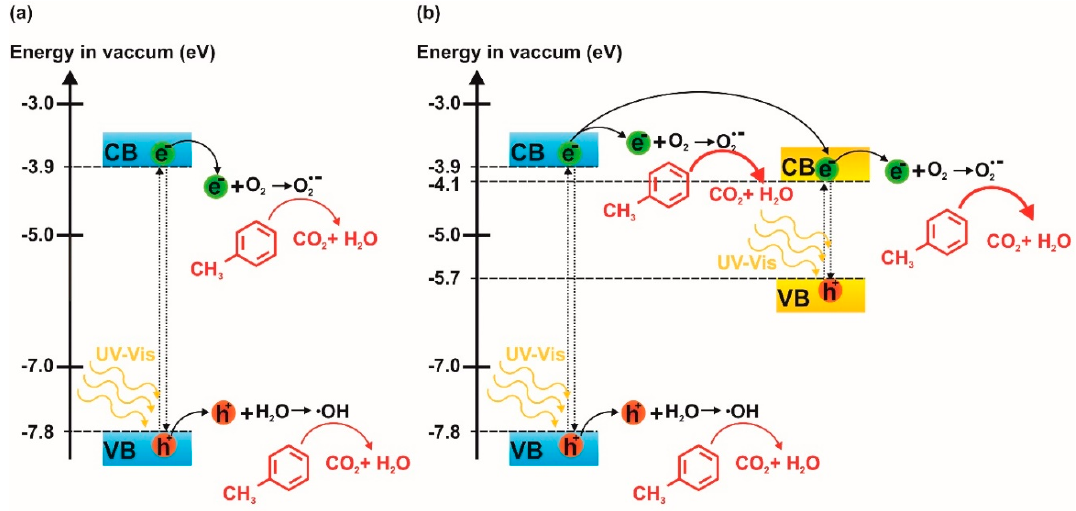
Figure 7. Proposed photodegradation mechanism for ( a ) nanotube arrays (NTs) and ( b ) NTs modified by quantum dots (QDs).